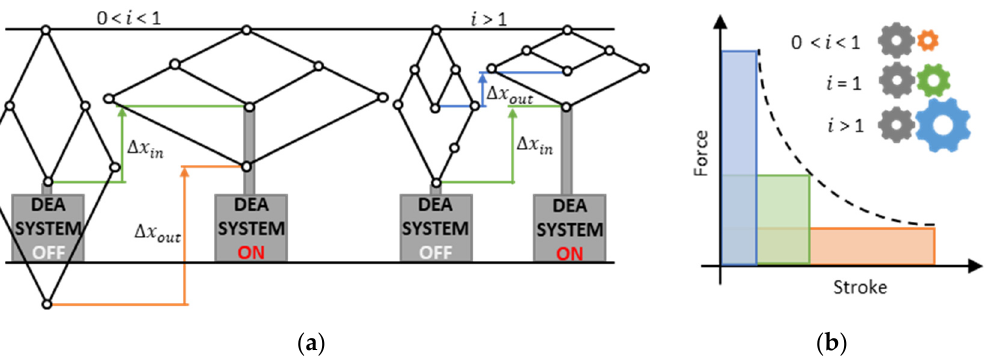
Figure 2. ( a ) Schematic concept illustration of a generic DEA system coupled to stroke magnifying and stroke reducing scissor linkages with input strokes ∆𝑥 (cid:3036)(cid:3041) and output strokes ∆𝑥 (cid:3042)(cid:3048)(cid:3047) , as well as ( b ) corresponding generic force-stroke characteristics for different transmission ratios